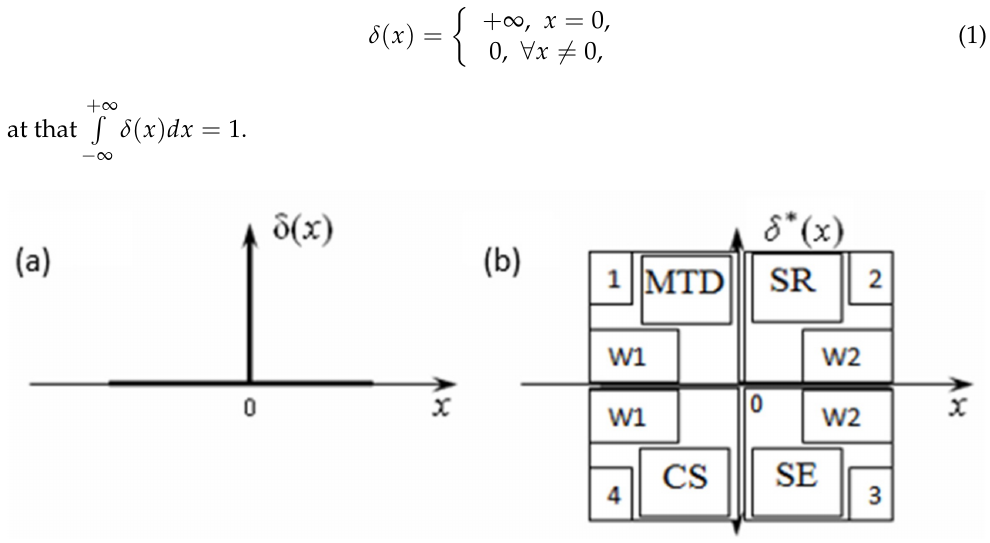
Figure 3. Representation of the delta function ( a ) and its approximation, taking into account the types of combination processes and organizational development of the system ( b ). MTD: medium technological development; SR: structurally revolutionary processes; CS: conservative self-organizing processes; SE: structural-evolutionary processes; W1, Where; W2, When; W3, What; W4, Why. The value x in this case is an indicator to assess the levels of energy,